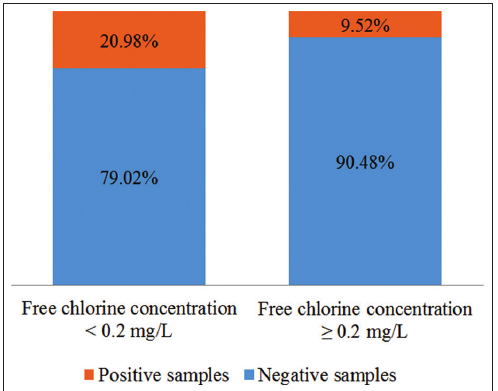
FIGURE 2. The comparison of positive and negative results with regards to the concentration of free residual